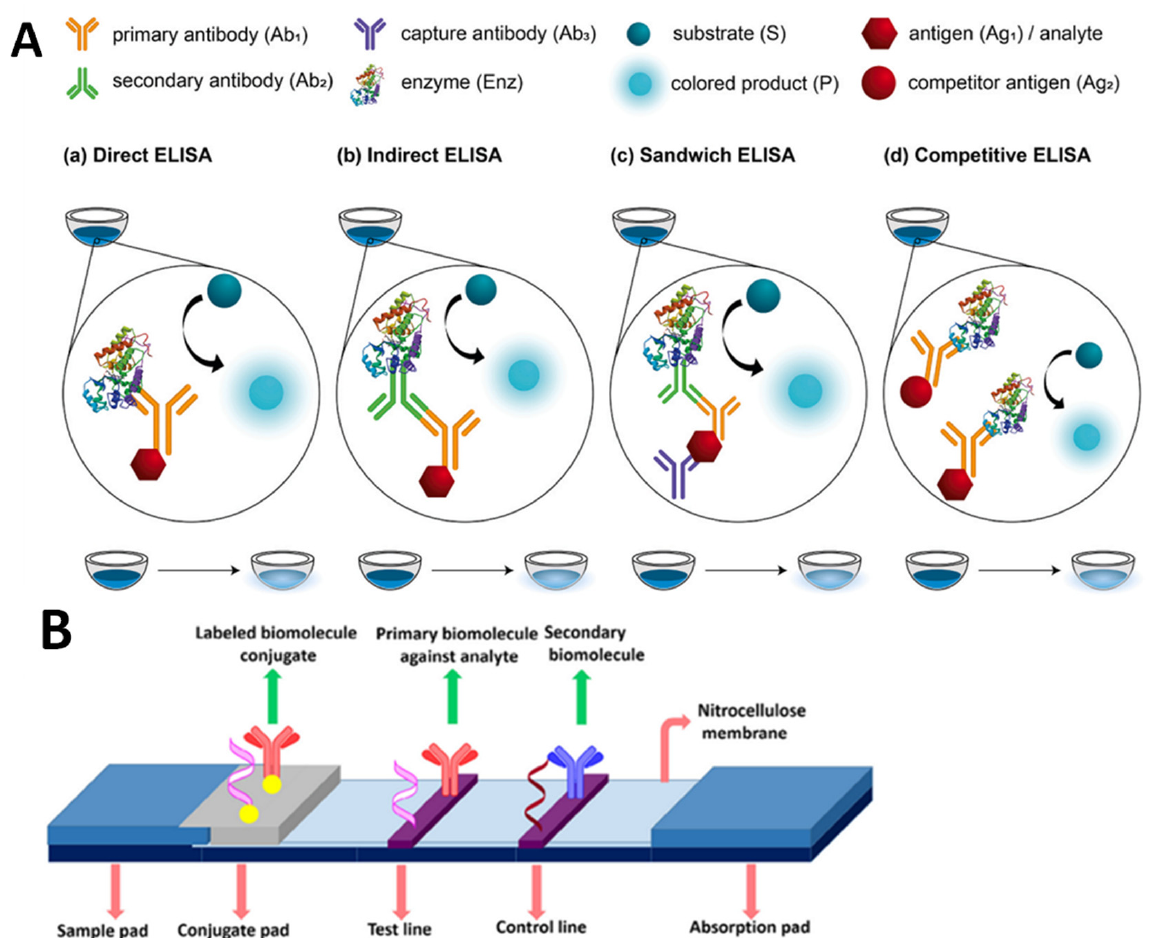
Figure 3. Schematic illustration of an immunoassay method. ( A ) Various types of ELISA (adapted from Ref. [29]). ( B ) The basic structure of lateral flow assay, reproduced from Bahadir and Sezgintürk [30].